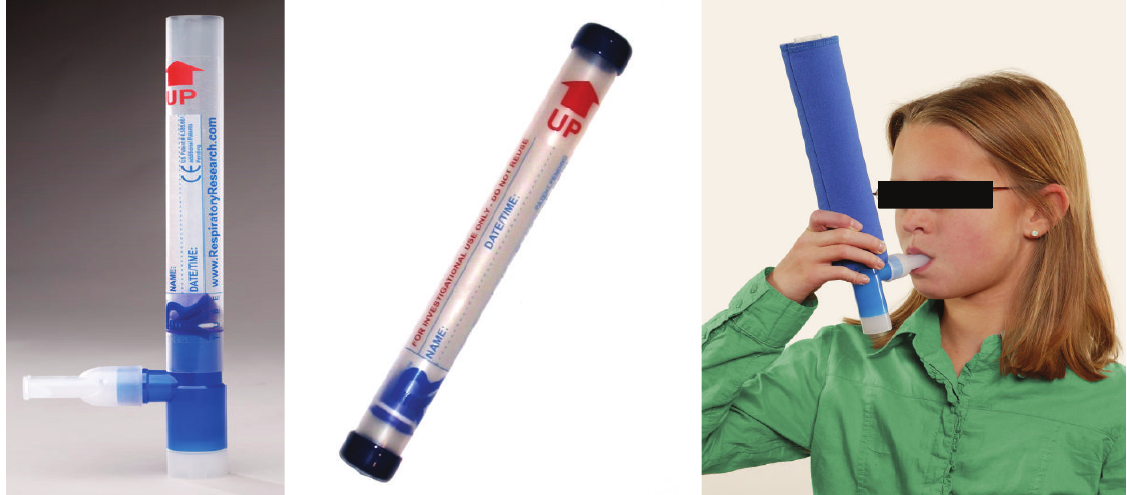
Figure3:RTubedeviceforexhaledbreathcondensate(EBC)collection(RespiratoryResearch,Inc.,USA).RTubedisposablecollectionsystem consists of a large Tee section (from polypropylene (PP)), which separates saliva from the exhaled breath, an one-way valve (from silicone rubber), and a PP collection tube, which is cooled by a cooling-sleeve placed around. RTube is portable and can be used by unsupervised subjects at home ( published with permission from Respiratory Research, Inc., USA